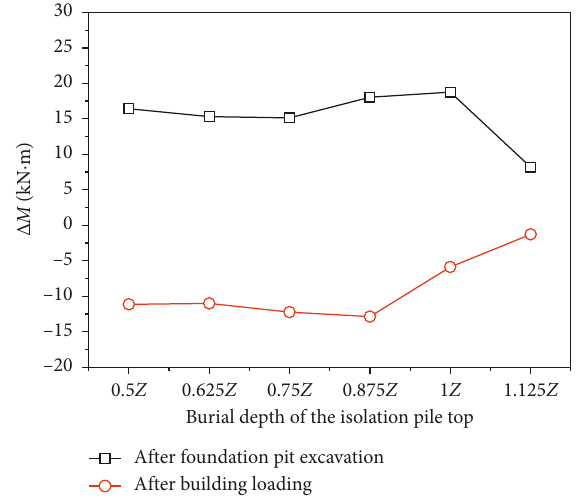
Figure 28: Difference between the additional bending moments.